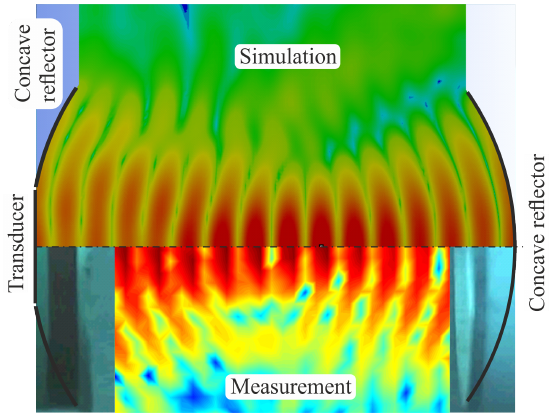
Figure 14. Comparison of simulated and measured field patterns for standing wave system with concave reflector on both sides ( R = 72 mm) at a distance of L = 7.5 λ ; sound pressure (model) and virtual velocity (experiment) are scaled logarithmically; f = 21.4 kHz; ˆ x = 19 µ m.